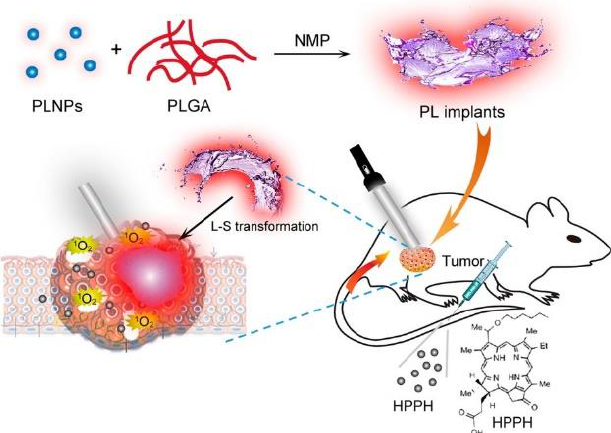
Figure 9. Schematic illustration of the construction of ZGC PL implants for in vivo LED/PersL–PDT upon LED irradiation. Reproduced with permission from W. Fan et al., ACS Nano; published by American Chemical Society, 2017 [239].